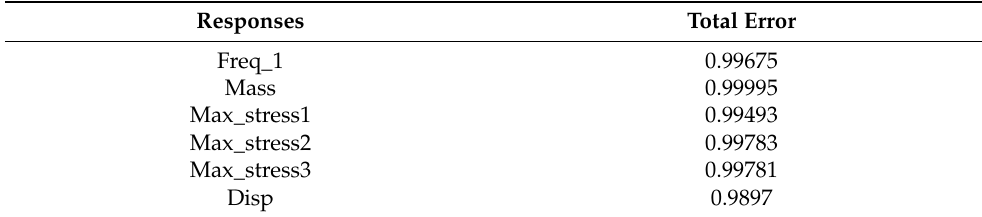
Table 4. Fitted R-squared values for each